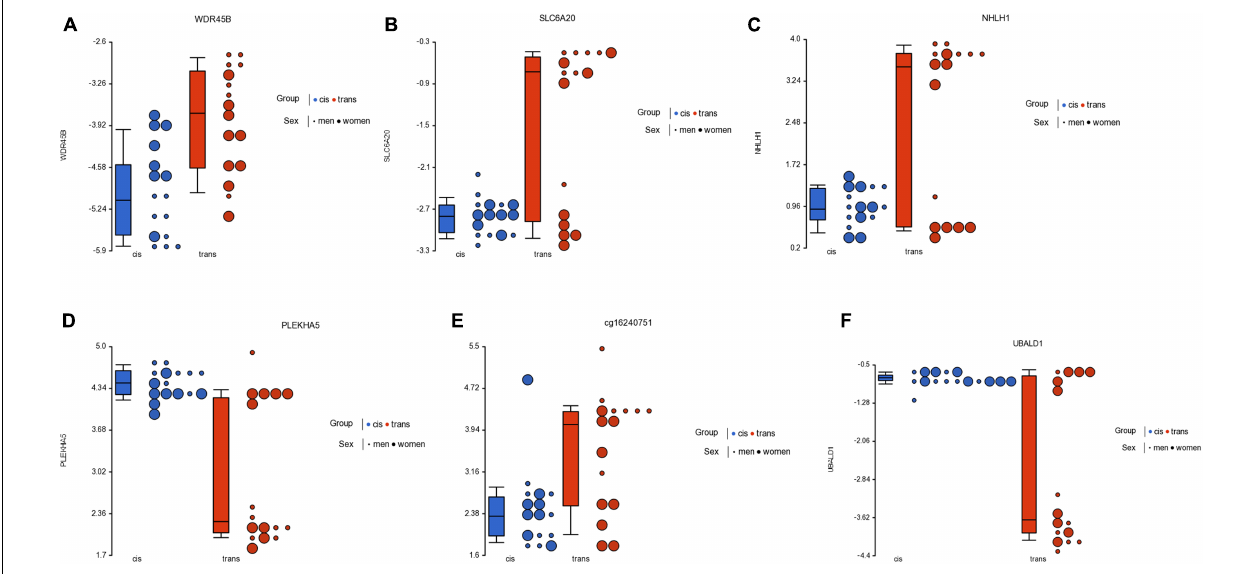
FIGURE 3 | Dot plot showing M -value data for genes WDR45B (A) , SLC6A20 (B) , NHLH1 (C) , PLEKHA5 (D) , one intergenic locus (cg16240751) (E) , and UBALD1 (F) , for cisgender vs. transgender populations by their sex assigned at birth. Each sample is represented by a dot, which corresponds to the overall degree of methylation ( M -value data). The samples are colored according to the levels of the variable “group” (blue for cisgender population and red for transgender population), and sized according to the levels of the variable “sex assigned at birth” (big for women and small for men). The middle line is the median, the box represents the upper and the lower quartile, while the whiskers correspond to the 90th and 10th percentiles of the data.